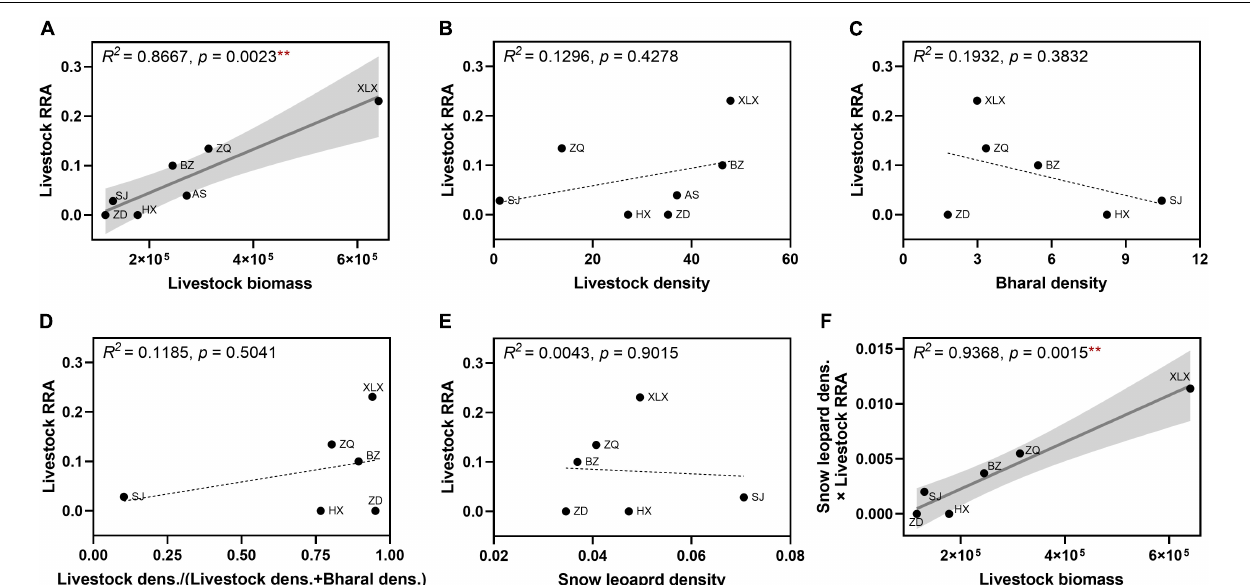
FIGURE 5 | Correlations between the proportion of livestock in snow leopard diets and (A–D) prey (livestock and bharal) abundance and (E) predator density, and (F) between total livestock consumption and livestock biomass at the study sites. Livestock biomass is measured in sheep units (SU). Livestock densities (in individuals/km 2 ) are based on the total number of livestock and the township area of each site. Bharal densities (in individuals/km 2 ) were estimated using double-observer surveys. Snow leopard densities (in independent captures/camera day) were estimated using camera-trapping data (see section “Materials and Methods” for details). Total livestock consumption was estimated as the product of livestock relative read abundance (RRA) and snow leopard density. Solid lines indicate statistically significant (at p < 0.05) linear regressions with the 95% confidence intervals shaded. Dotted lines indicate non-significant linear fits of the